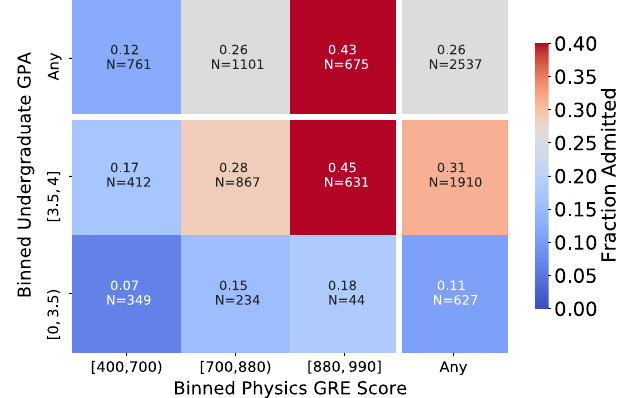
FIG. 4. A condensed version of Fig. 3 showing the fraction of applicants admitted by undergraduate GPA and physics GRE score.